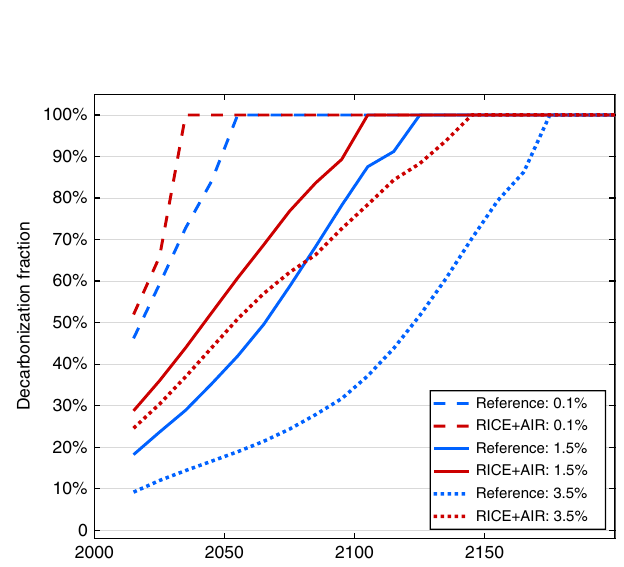
Fig. 5 The in fl uence of pure time preference. Optimal decarbonization with low (0.1%), medium (1.5%), and high (3.5%) rates of pure time preference for the reference case (that excludes health co-bene fi ts) and in the full RICE + AIR case (that includes health co-bene fi ts). All runs have a consumption elasticity of marginal utility of 1.5